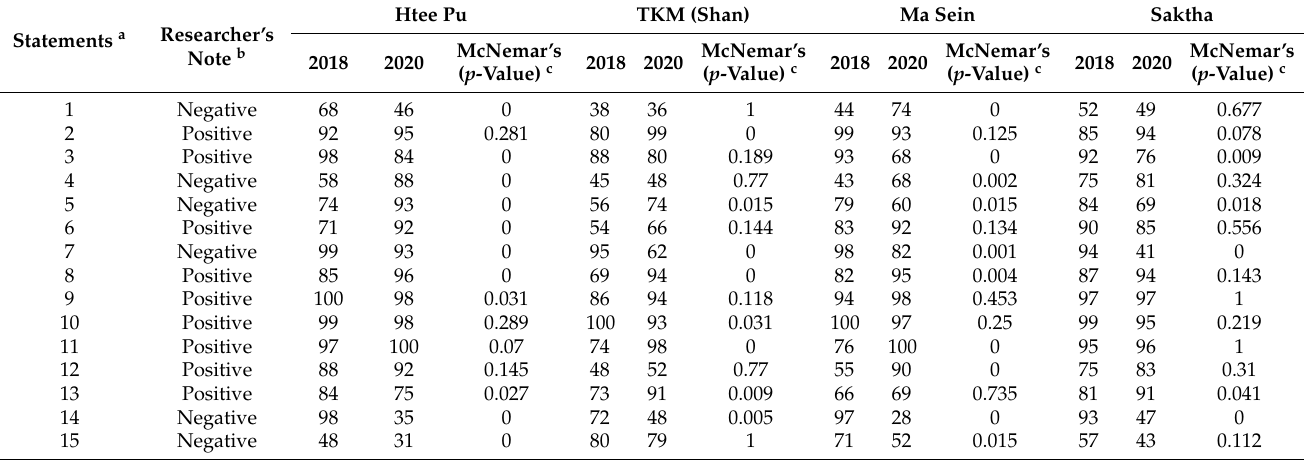
Table 7. Proportion of respondents who agree on the attitude statements in household nutrition in four